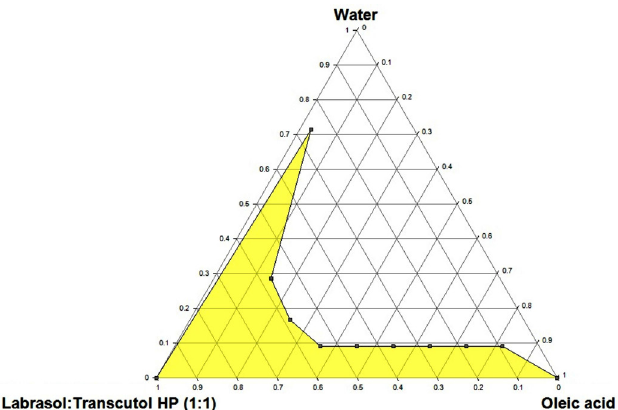
FIGURE 2 - Pseudo-ternary phase diagrams of Labrasol as surfactant in 1:1 ratio with Transcutol HP.